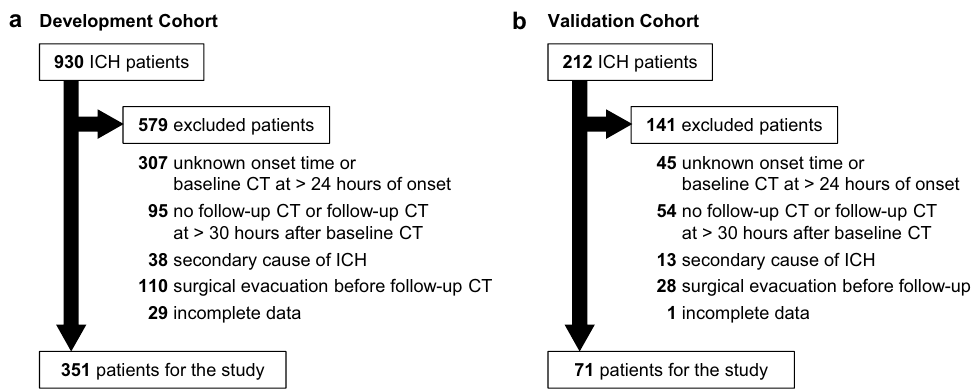
Figure 1. A flow chart indicating the included and excluded patients in the development cohort ( a ) and the validation cohort ( b ). ICH indicates intracerebral